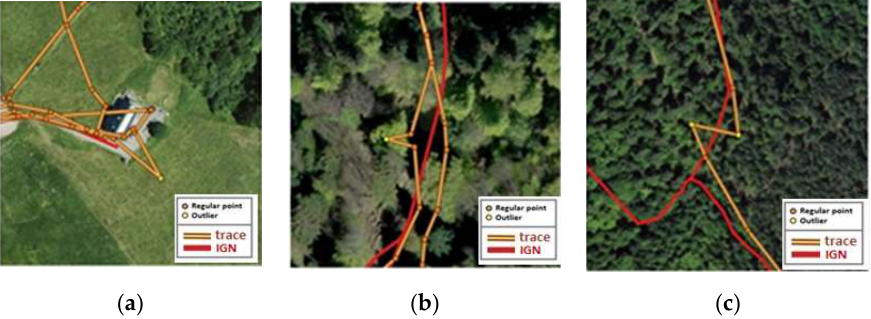
Figure 9. Typical outliers successfully detected: ( a ) By Rule 1; ( b ) by Rule 2; and ( c ) by Rule 3.